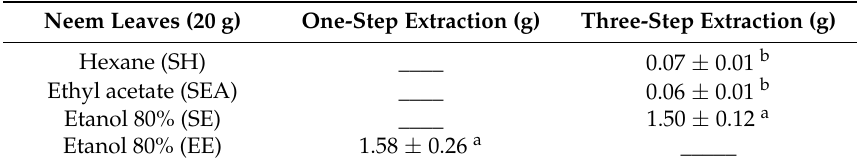
Table 1. Effect of different solvents, hexane (SH), ethyl acetate (SEA), and ethanol (SE and EE) on the dry mass of neem leaves in the PLE